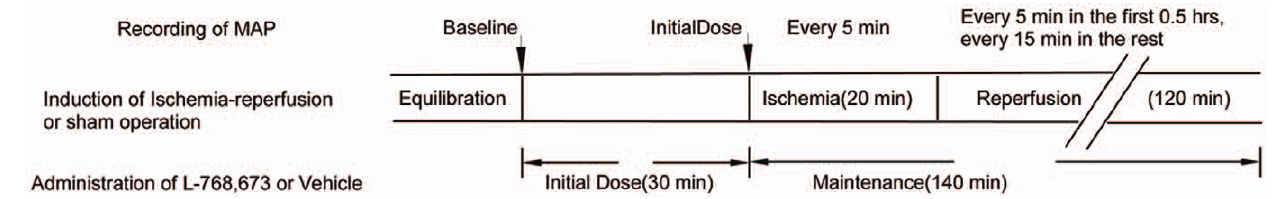
Figure 6. Study protocol 1 of experiments. Monophasic action potentials were recorded after the equilibration at both the middle of the infarct zone and the unaffected zone of the epicardium. For L-768,673, The infusion rate of the initial dose was 0.5 m g/kg/h for 30 min, and the maintenance rate was 0.25 m g/kg/h for two hours. MAP duration data were expressed as MAPD90/60/30 Baseline, Initial Dose, I5, I10, I15, I20, R5, R10, R15, R20, R25, R30, R45, R60, R75, R90, R105, R120 , which stood for MAPD90/60/30 recorded at baseline, after initial dose, at ischemia for 5 min, 10 min, 15 min, 20 min and at reperfusion for 5 min, 10 min, 15 min, 20 min, 25 min, 30 min, 45 min, 60 min, 75 min, 90 min, 105 min, 120 min, respectively.